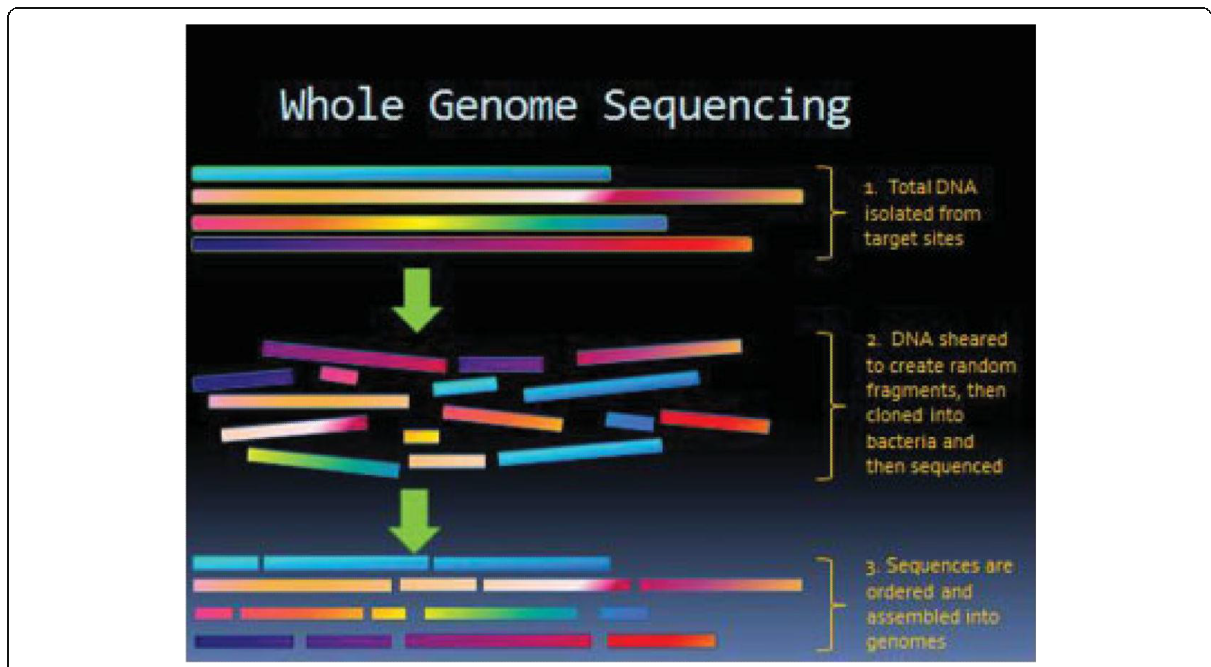
Fig. 2 Whole genome sequencing for microbiota